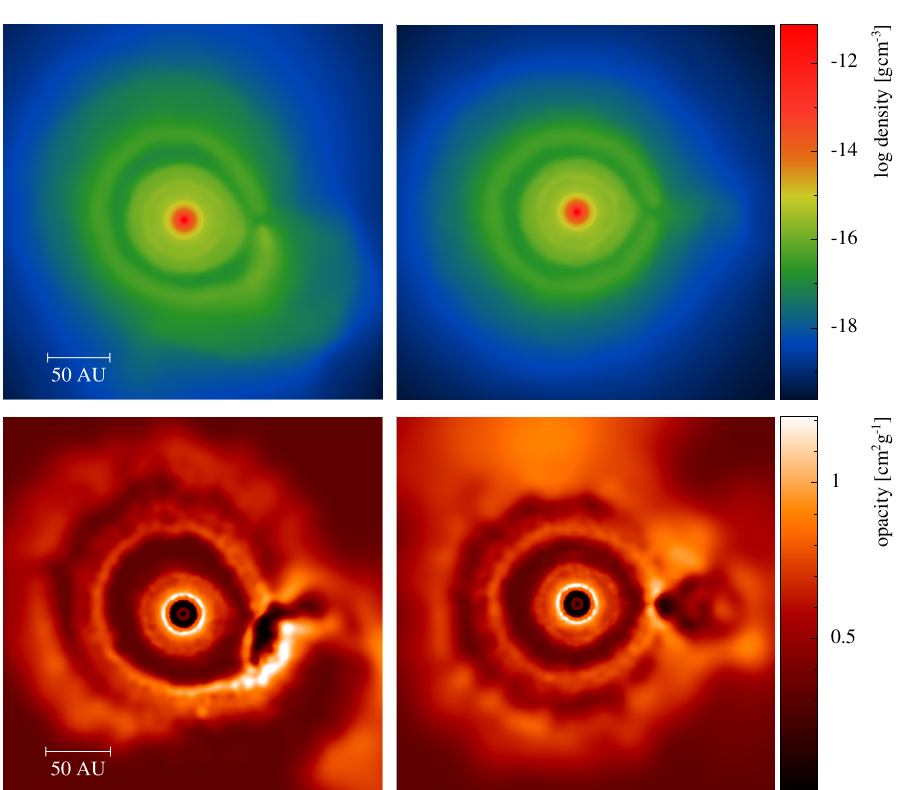
Fig. 4. The same as in Figure 3, but for model M2 where R dust =R L ; 1 <